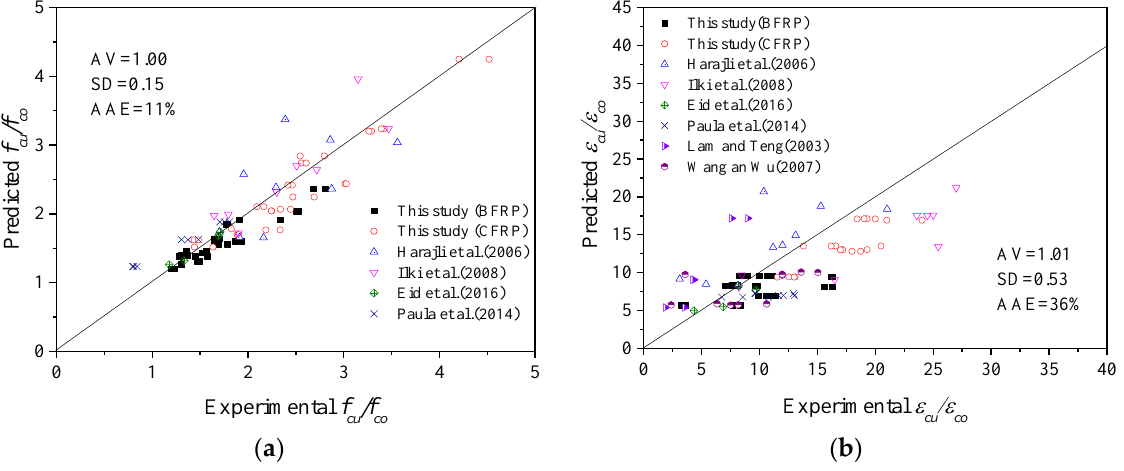
Figure 12. Comparison of the predicted results and test results of the ultimate point models: ( a ) ultimate stress; ( b ) ultimate strain.